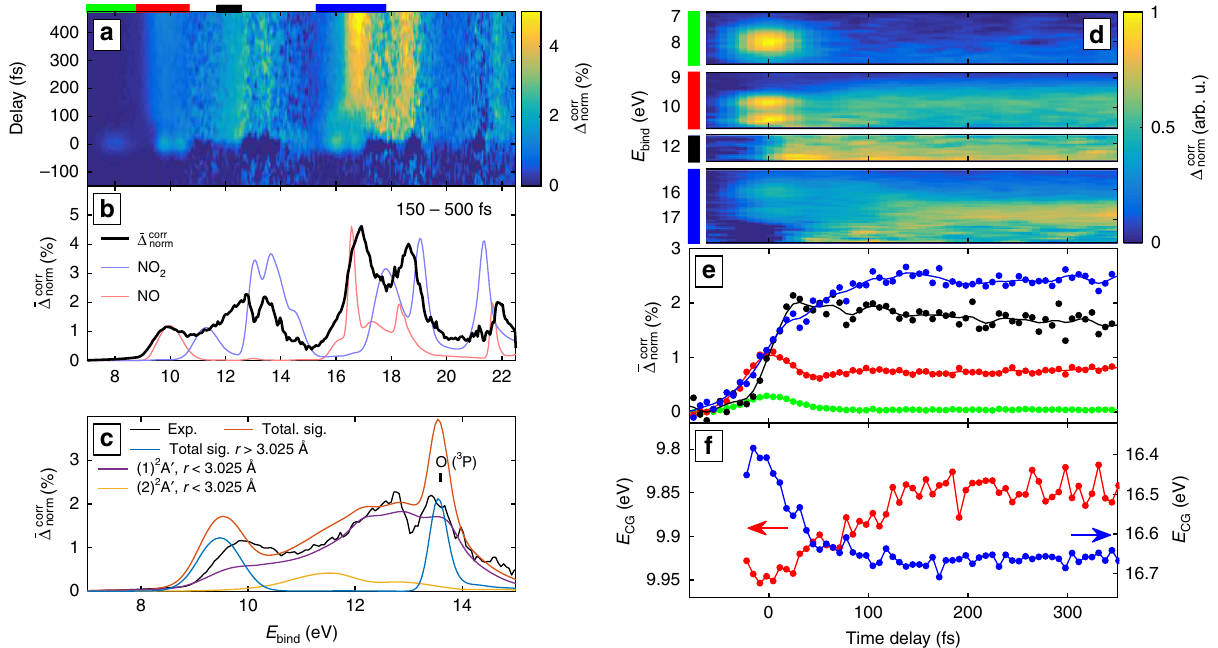
Fig. 4 Overview of the depletion-corrected excited-state photoelectron spectrum and its time dependence. a Dataset from Fig. 3b) after depletion correction (see text). The excitation was determined to be 1.3%. b Mean difference spectrum outside of the temporal overlap (cf. Fig. 3d). XUV only spectra of both NO 2 and NO are overlayed to indicate the origin of individual contributions. The NO spectra were acquired with a different magnetic-bottle spectrometer 61 . c Same data with the region between 7 and 15 eV magni fi ed and superimposed calculated spectra. The binding energy range matches the energies where the cationic states included in our model, suf fi ce to describe the system. The corresponding energy domains are labeled by bars of the same colors in a . d The four selected bands described in the text, each renormalized to a peak amplitude of 1. e Mean variation of each band as a function of time delay and f The center of gravity calculated for two selected bands. The color code of the bands in d – f is